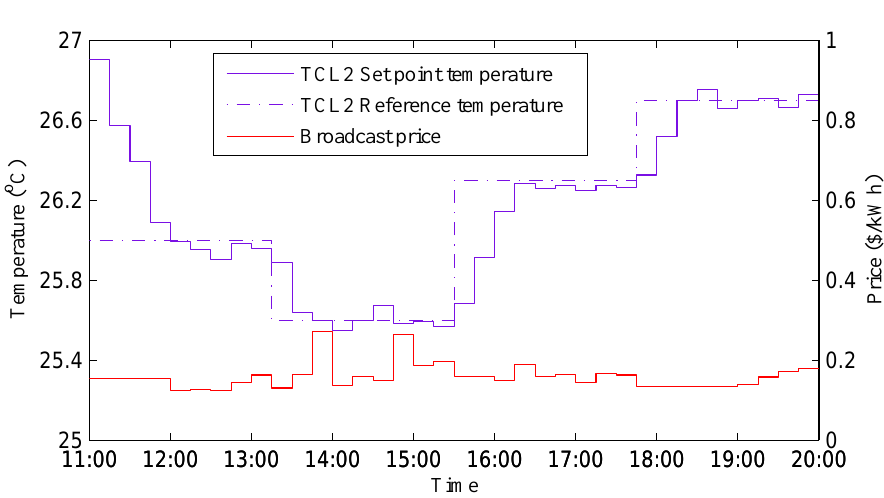
Figure 11. Heterogeneous TCLs: set-point temperature of TCL1.